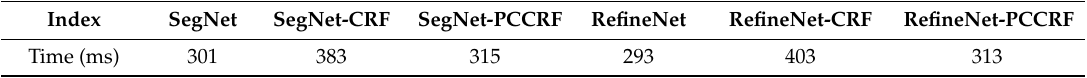
Table 4. Statistical comparison of model